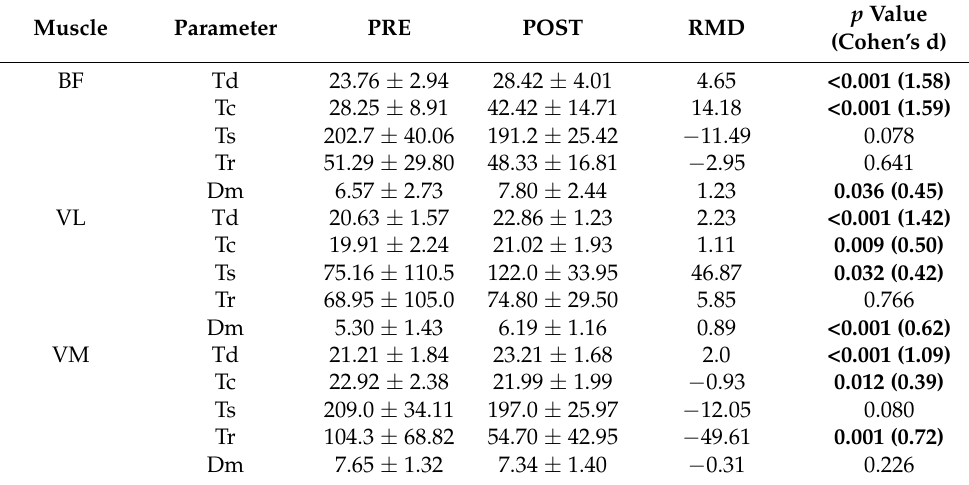
Table 1. Comparison of the tensiomyographic characteristics of dominant leg muscles at baseline, from pre-lockdown, (PRE) to post-COVID-19 lockdown